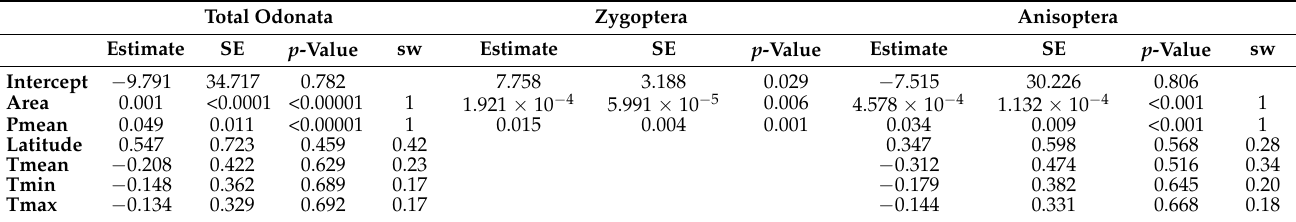
Table 1. Results of multimodel selection for the influence of geographical and climatic variables on odonate richness in Italy. For the total Odonata and Anisoptera, model-averaged coefficients (full average) are given; for the Zygoptera only one model was selected on the basis of AICc values. p -values are calculated as probability > |z| for the model-averaged coefficients of total Odonata and Anisoptera, and as probability > | t | for the single model obtained for Zygoptera. SE: standard error; sw: sum of weights; Pmean: total annual precipitation; Tmean: average annual temperature; Tmin: mean minimum temperature; Tmax: mean maximum